Question: Express in one sentence what the figure is showing.
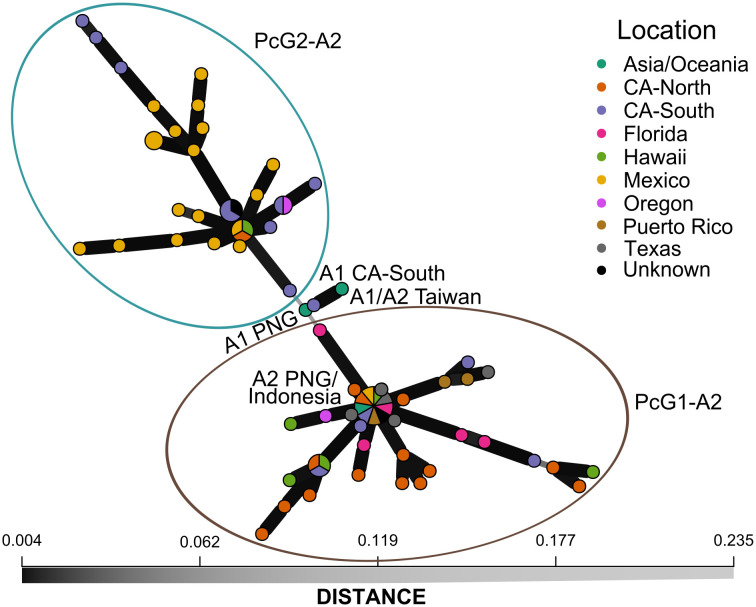
Answer: Minimum spanning network (MSN) analysis of multilocus genotypes (MLGs) showing the genetic relationships across samples from different locations and collection years. The MSN plot was generated using pairwise distances between each sample, where edge thickness represents the genetic distance. Phytophthora cinnamomi A2 panglobal clonal lineages are displayed as brown (PcG1-A2) and blue (PcG2-A2) ellipses. Nodes containing reference isolates from Asia and Oceania are also indicated. Nodes in each plot represent a single MLG, with node size proportional to the number of representative genotypes. Pie chart colors within node represent the proportion of individuals from each geographical location: Asia/Oceania = teal, CA-North = orange, CA-South = blue, Florida = pink, Hawaii = green, Mexico = yellow, Oregon = purple, Puerto Rico = brown, Texas = gray, and Unknown region from California = black.